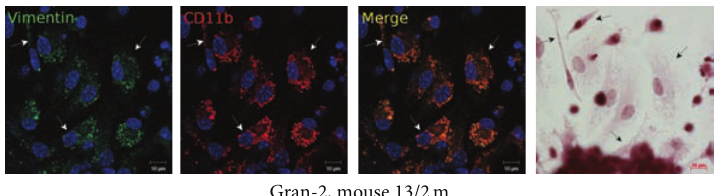
Figure 13: Confocal immunofluorescent localization of vimentin (green signal) and CD11b (red signal) in the cells in a fragment of a mouse splenic granuloma. The scale bars are 10 𝜇 m each. Colocalization of the markers on the confocal images of cells (yellow signal). Nuclei are stained by DAPI (blue signal). In the right panel, the same fragment as in the other panels restained for acid-fast BCG-mycobacteria by the ZN method. Macrophages with BCG-mycobacteria reproducing in them are indicated by the white arrows on the fluorescent images and the black arrows on the ZN image. Abbreviations as in Figure 1.